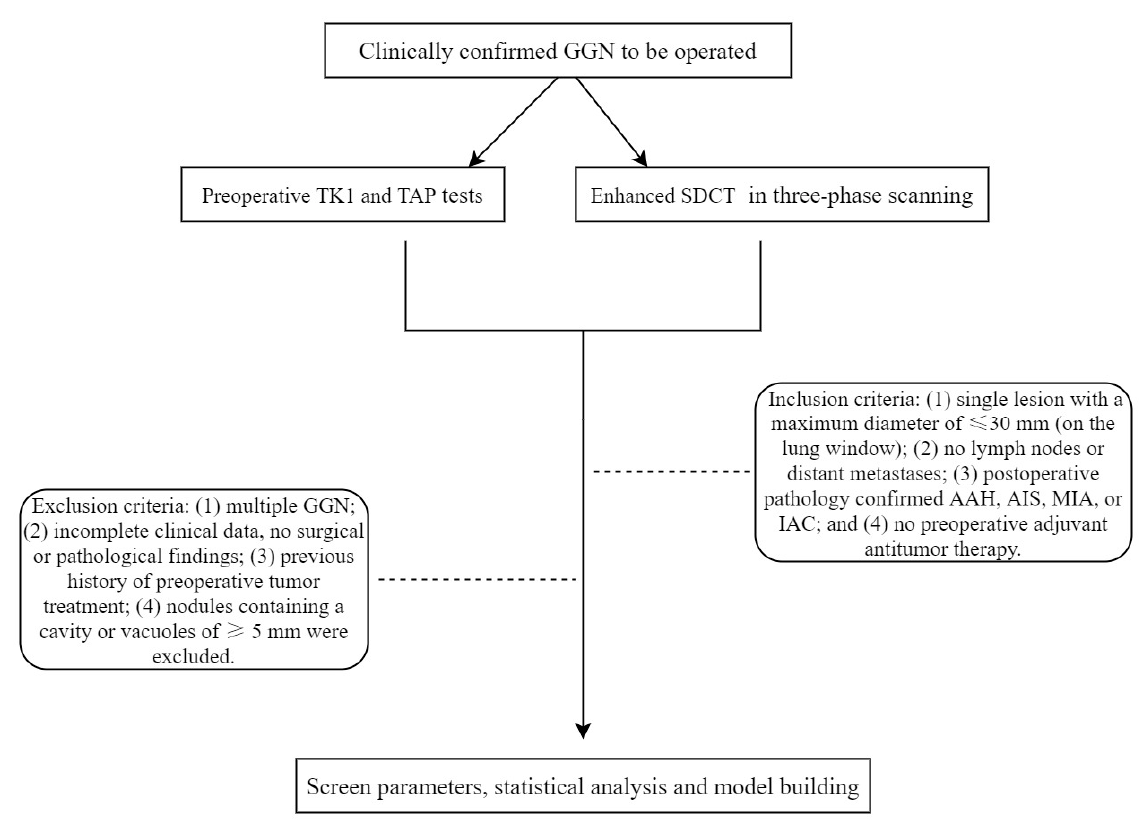
Figure 1. Study flow chart. GGN, ground-glass nodule; TK1, thymidine kinase-1; TAP, tumor abnormal protein; SDCT, spectral dual-layer detector-based computed tomography; AAH, atypical adenomatous hyperplasia; AIS, adenocarcinoma in situ; MIA, minimally invasive adenocarcinoma; IAC, invasive adenocarcinoma.